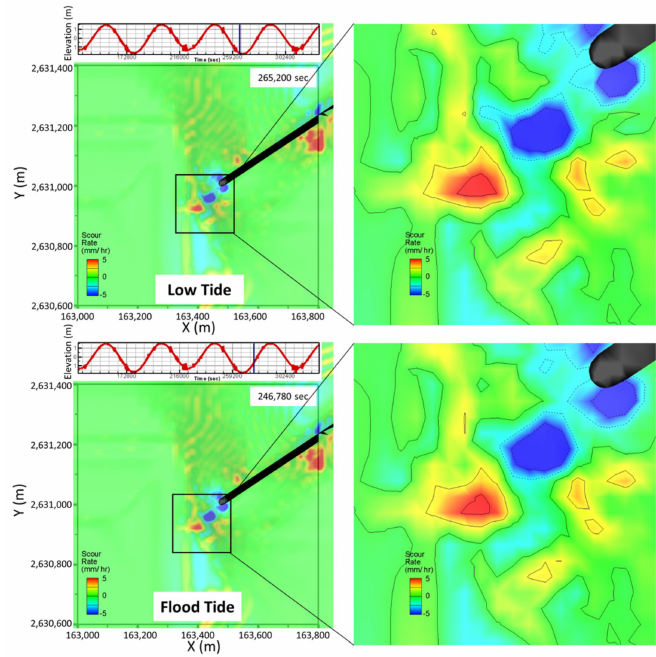
Figure 40. Topographic changes at low and flood tide stages.